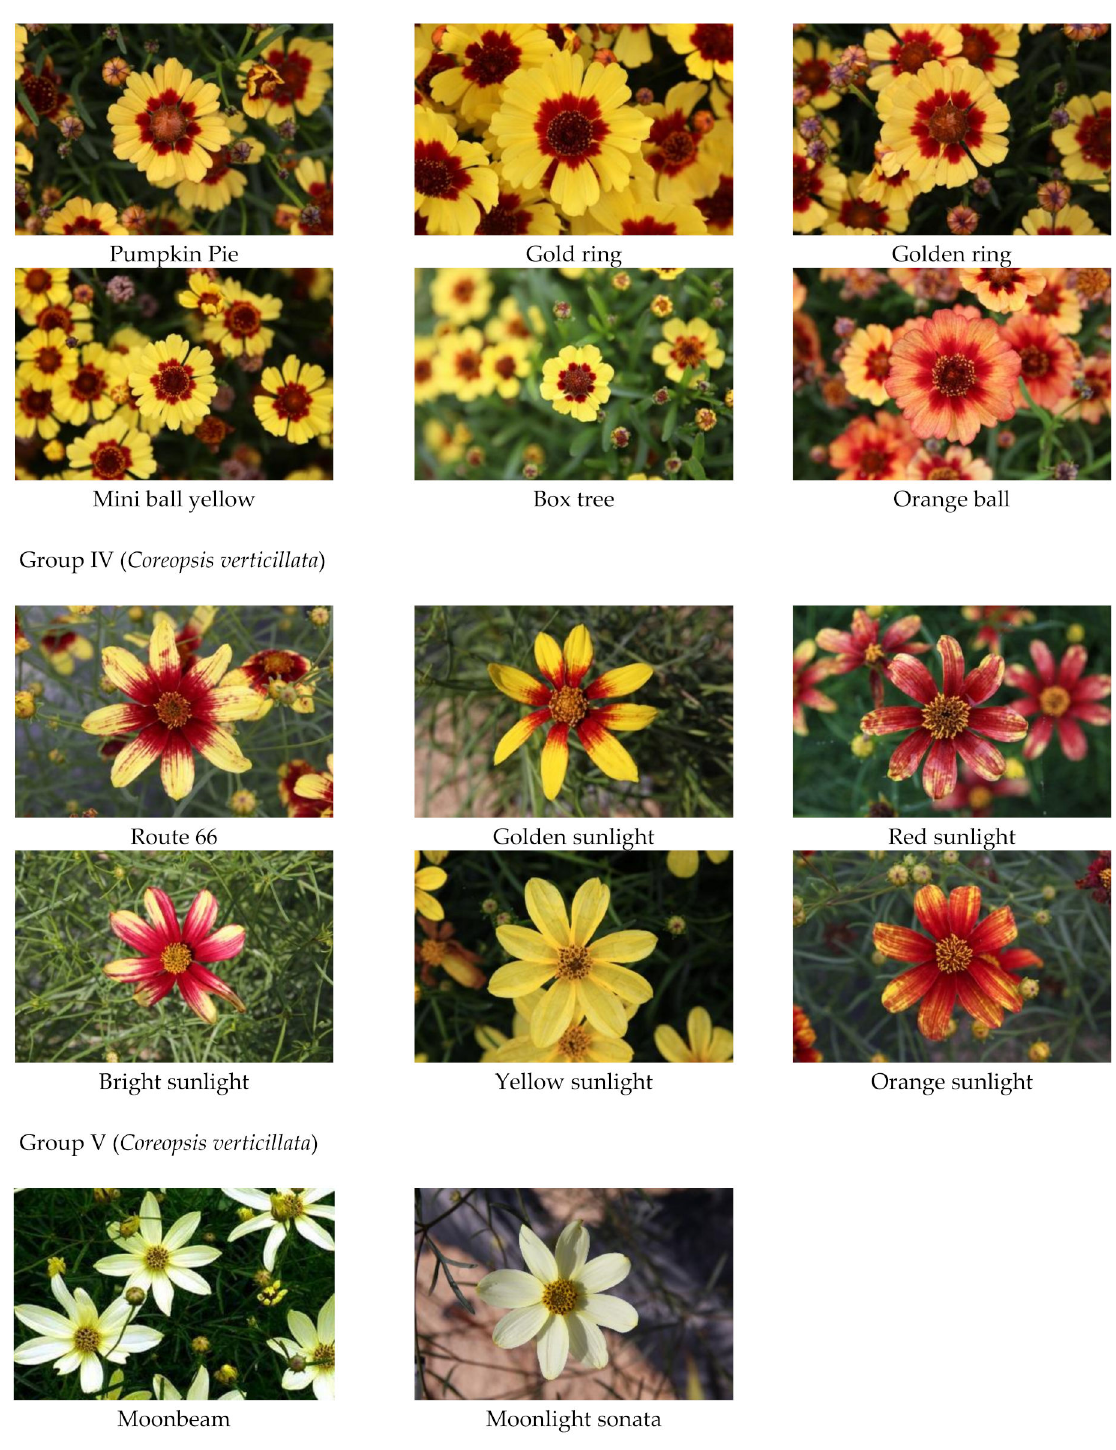
Figure 1. Photos of original and mutant cultivars of Coreopsis rosea and Coreopsis verticillata used in this study. As part of our investigation of the effects of mutation on metabolic changes between the original mutant cultivars and their biological functions, we analyzed metabolite pro- filing of the five original cultivars and each mutant cultivar. Given that Coreopsis species have been known to be effective for diabetes in folk medicine, 70% methanol extracts of 32 Coreopsis samples were evaluated for their inhibitory effect against dipeptidyl peptidase (DPP)-IV, a target of incretin-based therapies for the treatment of type 2 diabetes